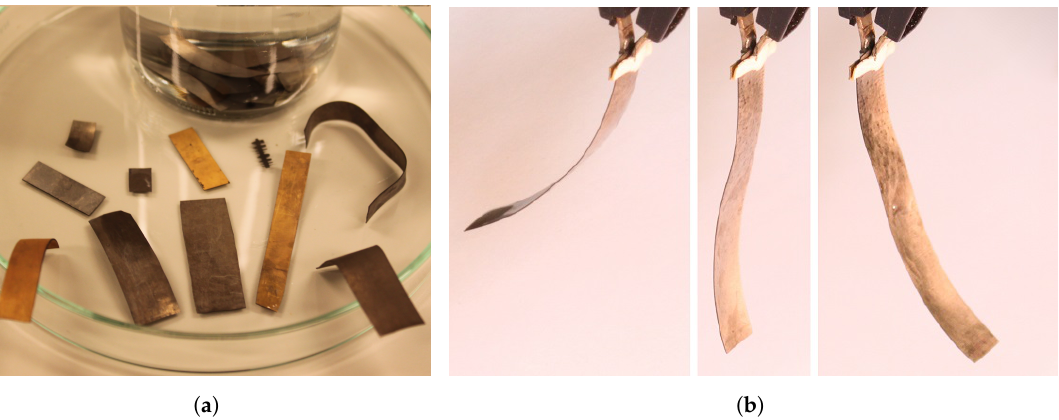
Figure 1. ( a ) IPMC samples of different types and geometries. ( b ) IPMC actuation: bending in response to application of 2.5 V input at opposite polarities (left and right), and IPMC at rest (middle).